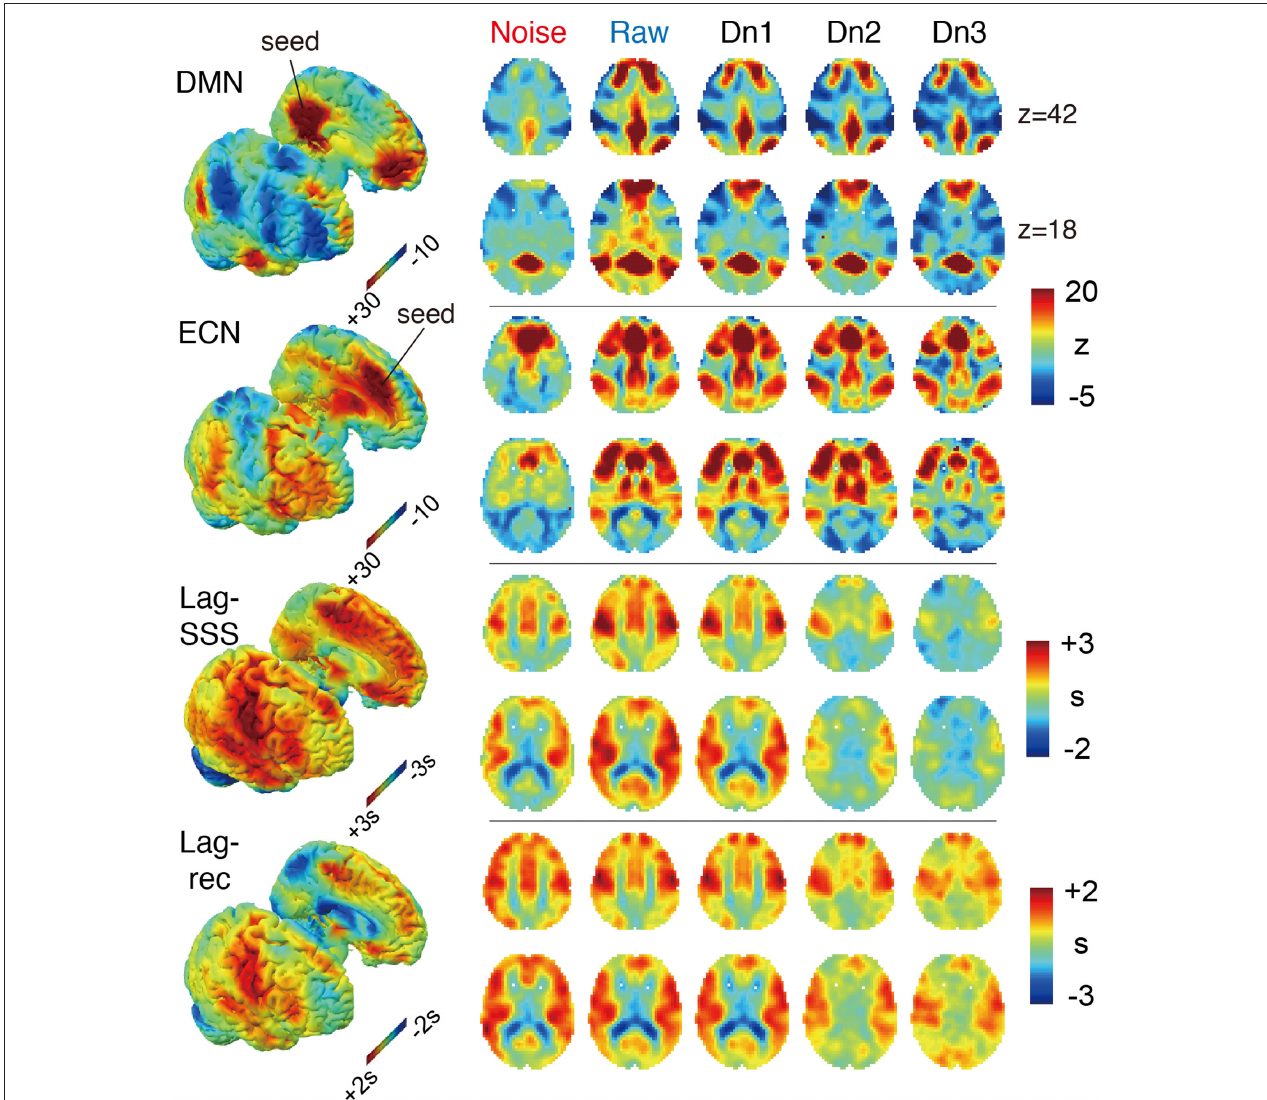
FIGURE 3 | The four BOLD-based metric maps investigated in the study and the effect of denoising intensity on the images. In the 3D rendered brain on the left, the right and left hemispheres are split to show the medial surface. For the Lag maps, we assigned positive values to the voxels with earlier phase to make the map represent travel time to the global signal phase. Both FC maps presented higher specificity with more contrast between the members and non-members of the networks. Denoising had the opposite effect on the two lag maps, which was most prominent in the noise-only dataset (Noise), which showed similar results to the raw maps.